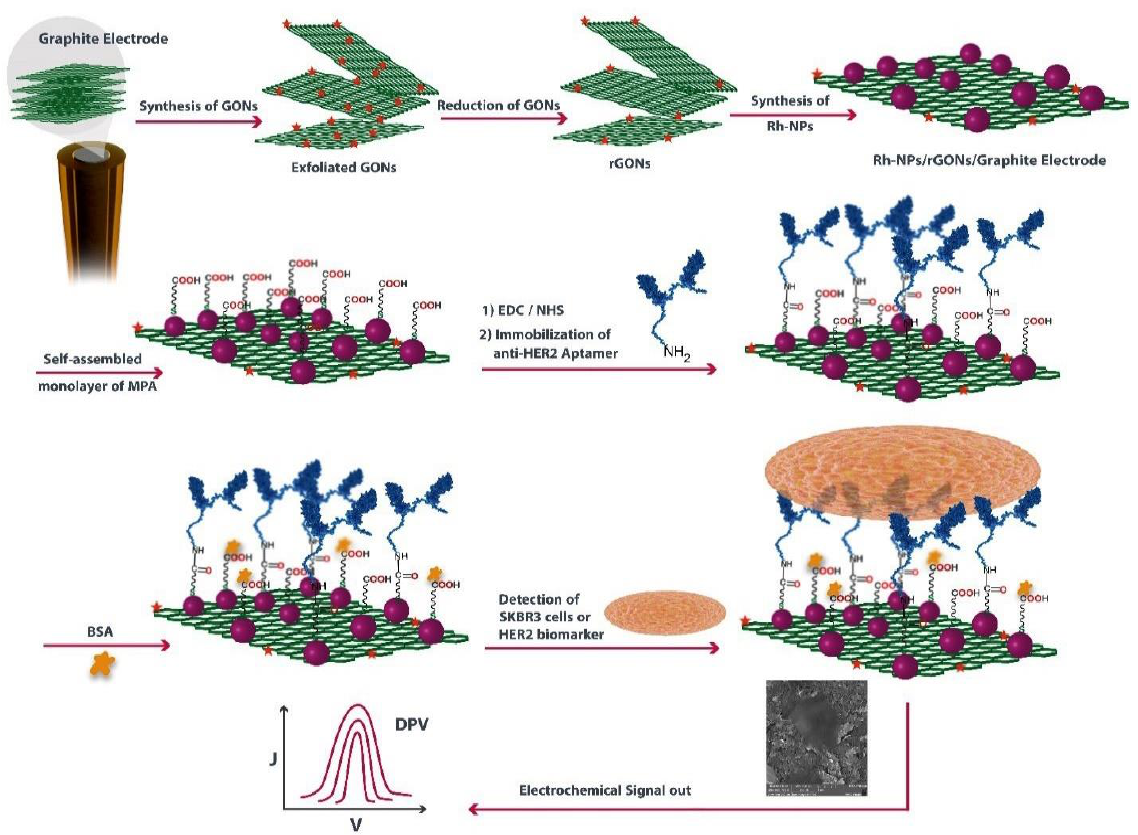
Figure 4. The fabrication process of aptasensor for detecting HER2 oncomarker: (i) the synthesis of rGO nanosheets, (ii) the synthesis of rhodium NPs, (iii) the immobilization of anti-HER2 aptamer strands, and (iv) the detection of HER2+ BC cell using the proposed aptasensor [131]. An xFe 2 O 3 -nPt@graphene (nPt-xFe 2 O 3 )-coated graphene nanostructure was effec-